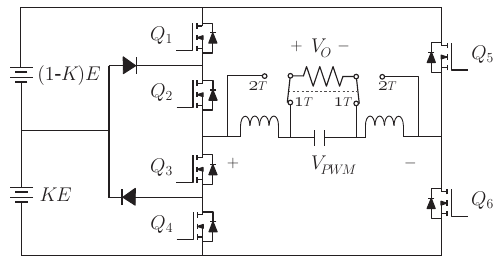
Figure 1. Asymmetric full-bridge multilevel inverter